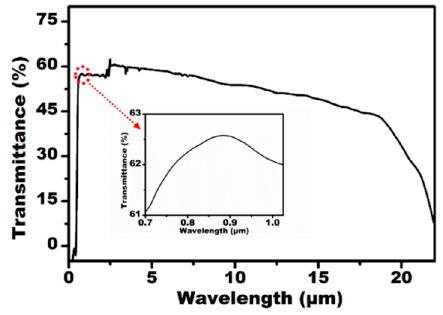
Figure 3. The measured transmittance of the ZnSe MLA.